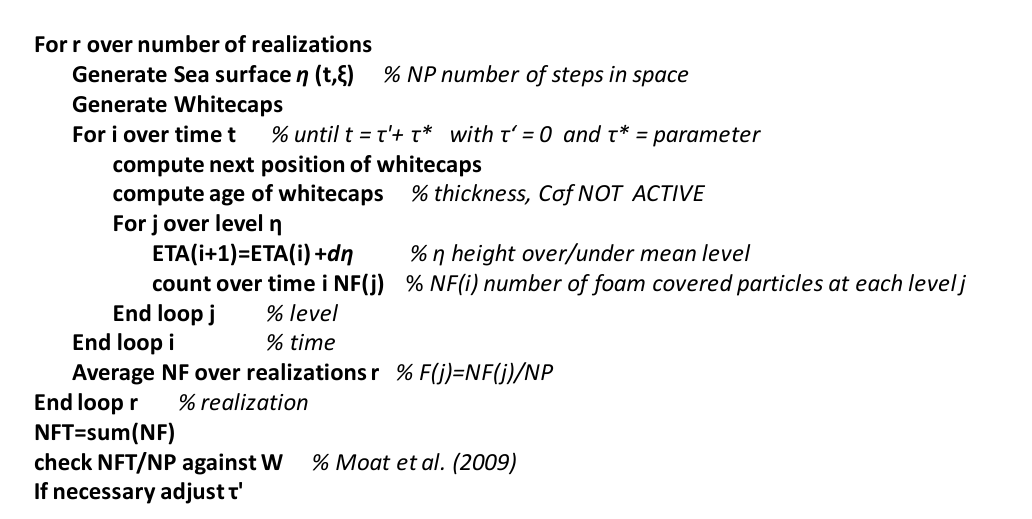
Figure 5. Simulation procedure for fractional foam surface pseudo-code (comments in